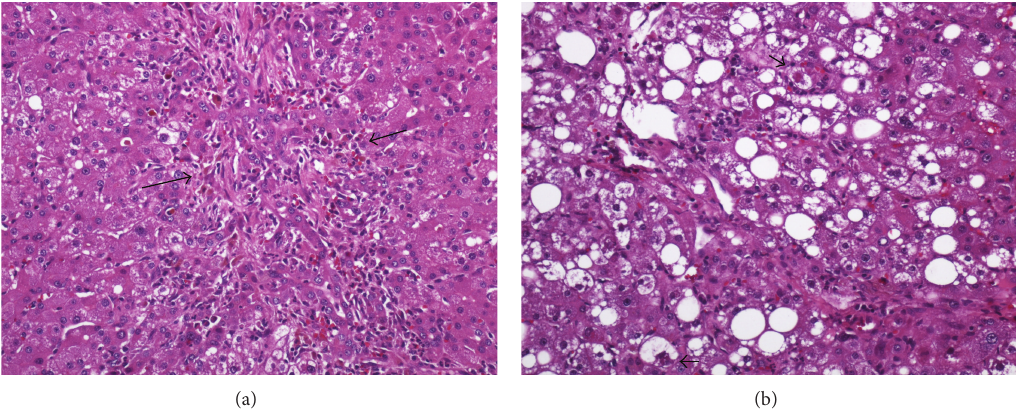
Figure 1: A 40-year-old man with NASH with severe activity (grade 3 of 3) and transition to cirrhosis (stage 3 of 4). (a) Hepatocellular adenoma containing portal tract-like structures with mild inflammation and marked ductular reaction (arrows). Steatosis is absent (H&E stain, × 100). (b) Nontumoral liver with severe ballooning degeneration of hepatocytes. Some of the ballooned hepatocytes contain Mallory- Denk hyalines (H&E stain, ×